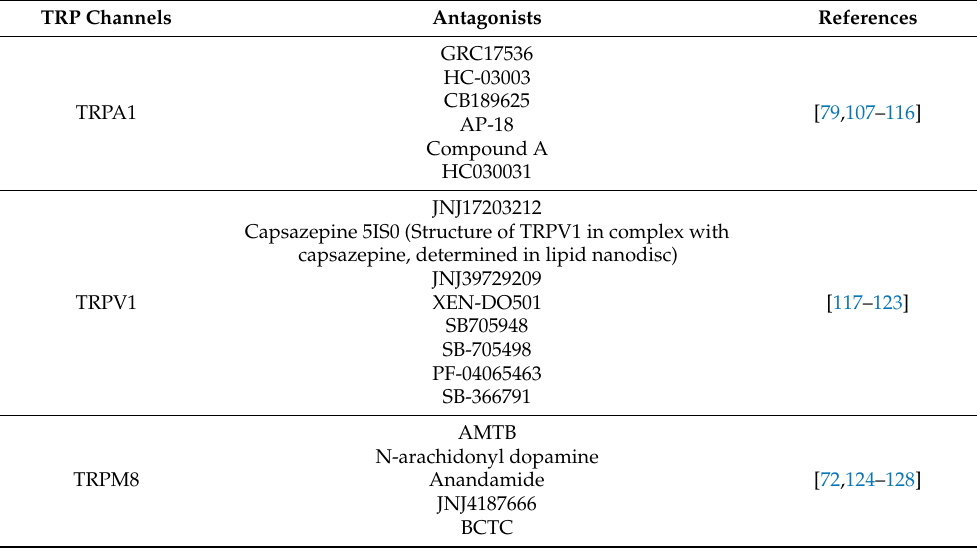
Table 6. Pharmacological modulators for TRPA1, TRPV1, and